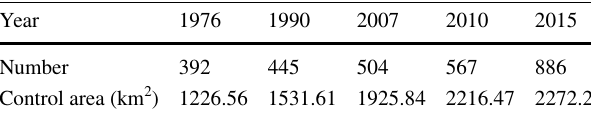
Table 10 Statistics of main parameters of check dam in each